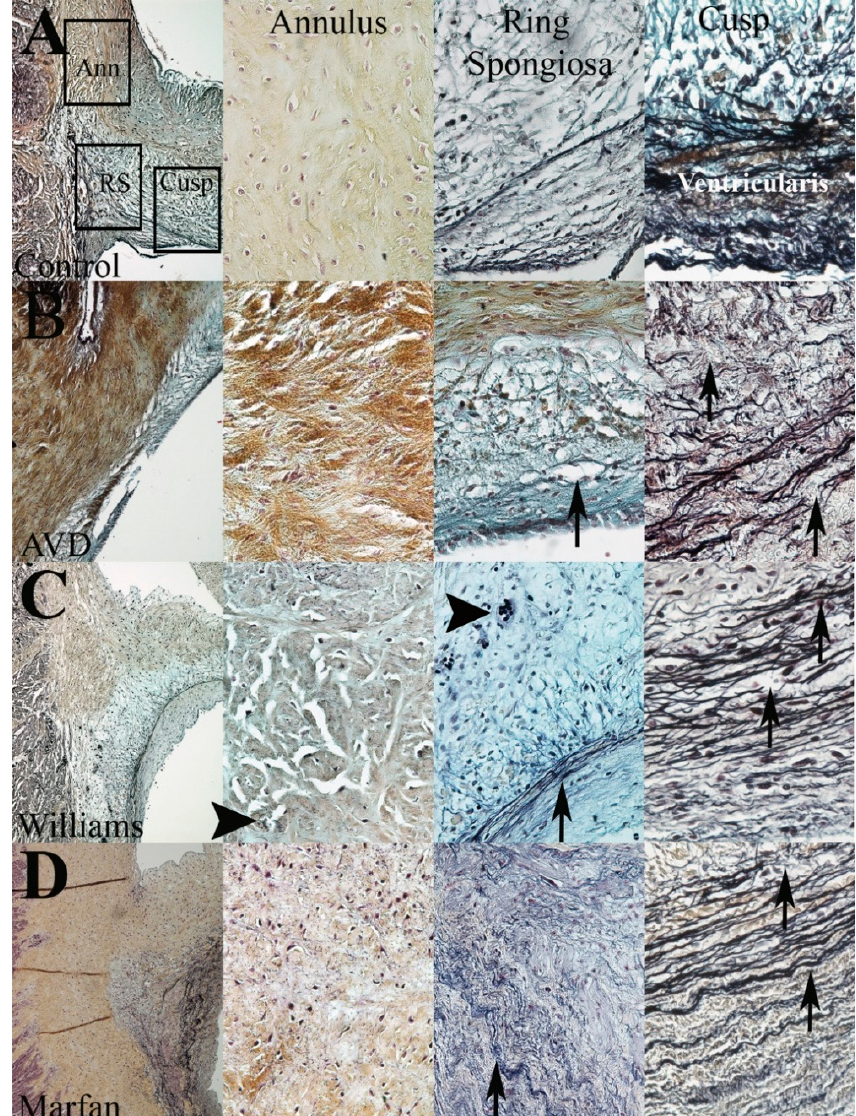
Figure 3. Elastic fiber dysregulation impacts regional aortic valve structure. Regional aortic valve tissue (annulus, ring spongiosa, cusp) from control ( A ), early-onset AVD ( B ), WS ( C ), and MFS ( D ) specimens demonstrate specific differences in matrix organization. EFF in WS and MFS is different (arrows, C vs. D ). Neovessels are seen in WS (arrowhead, C ) but not MFS.